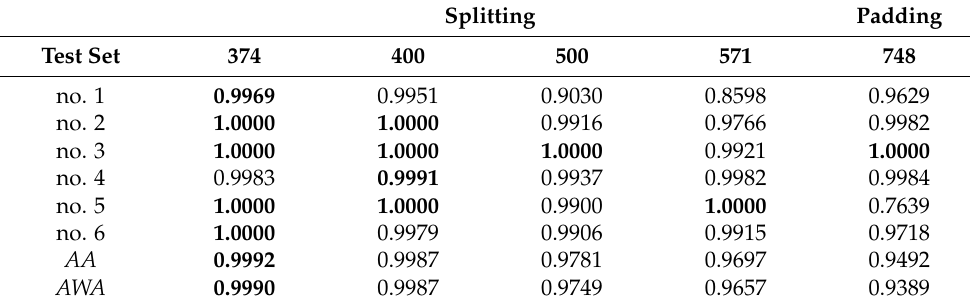
Table 6. Test results of models trained using time series of different lengths.